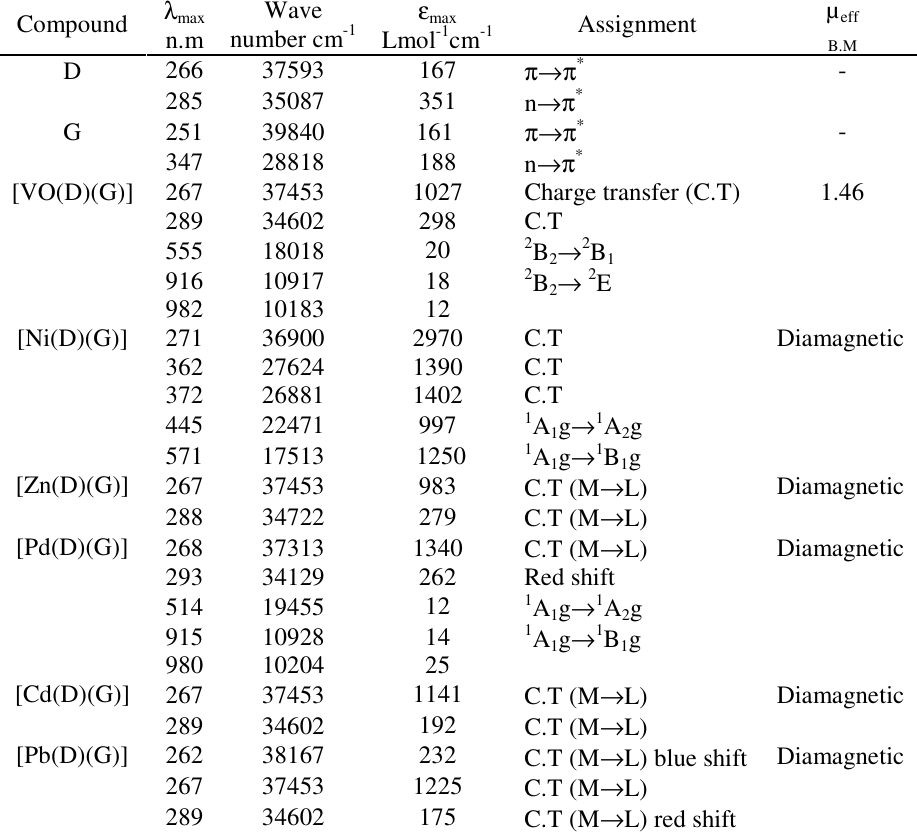
Table 5. The electronic spectra data and magnetic moments for the compounds